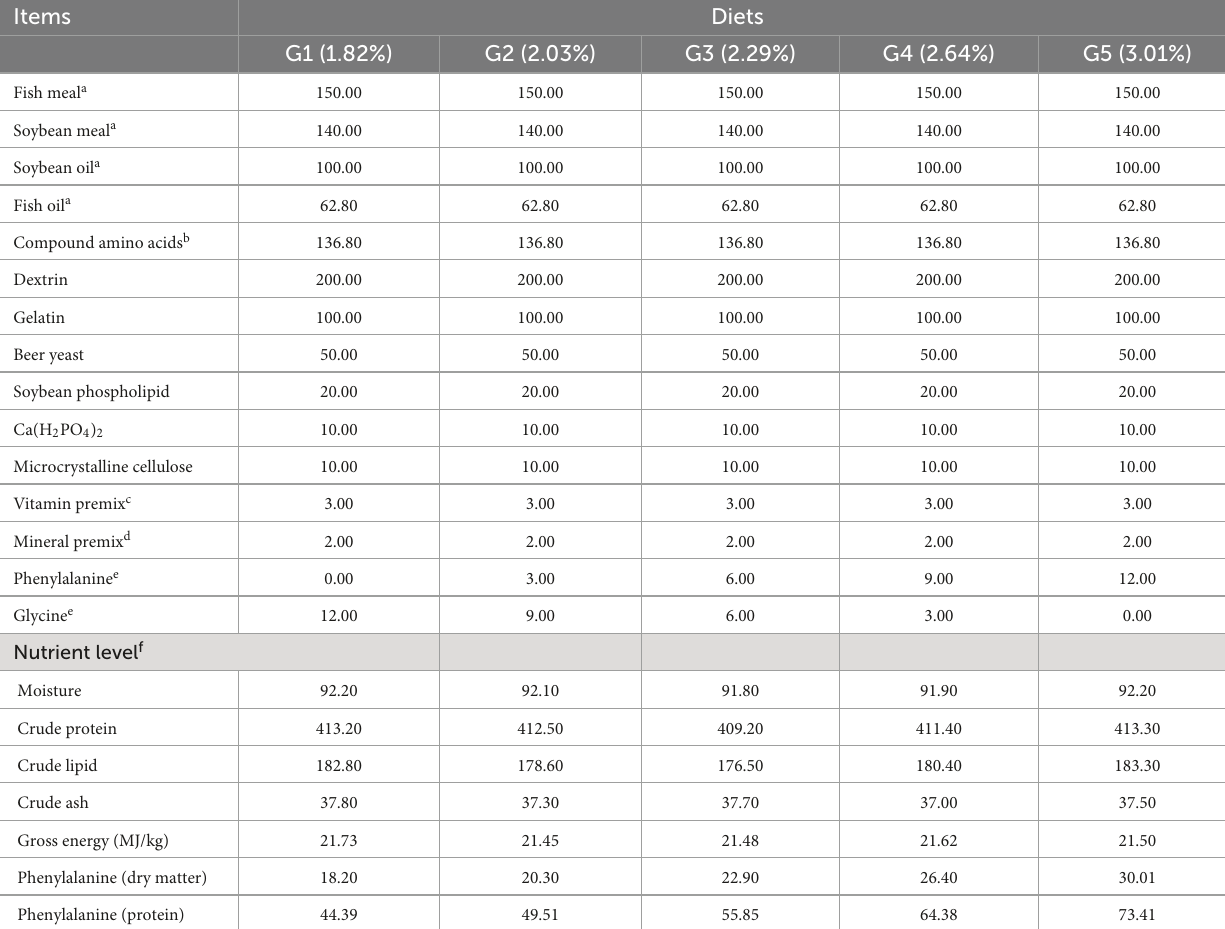
TABLE 1 Experimental diet composition and nutrient levels (air-dry basis,